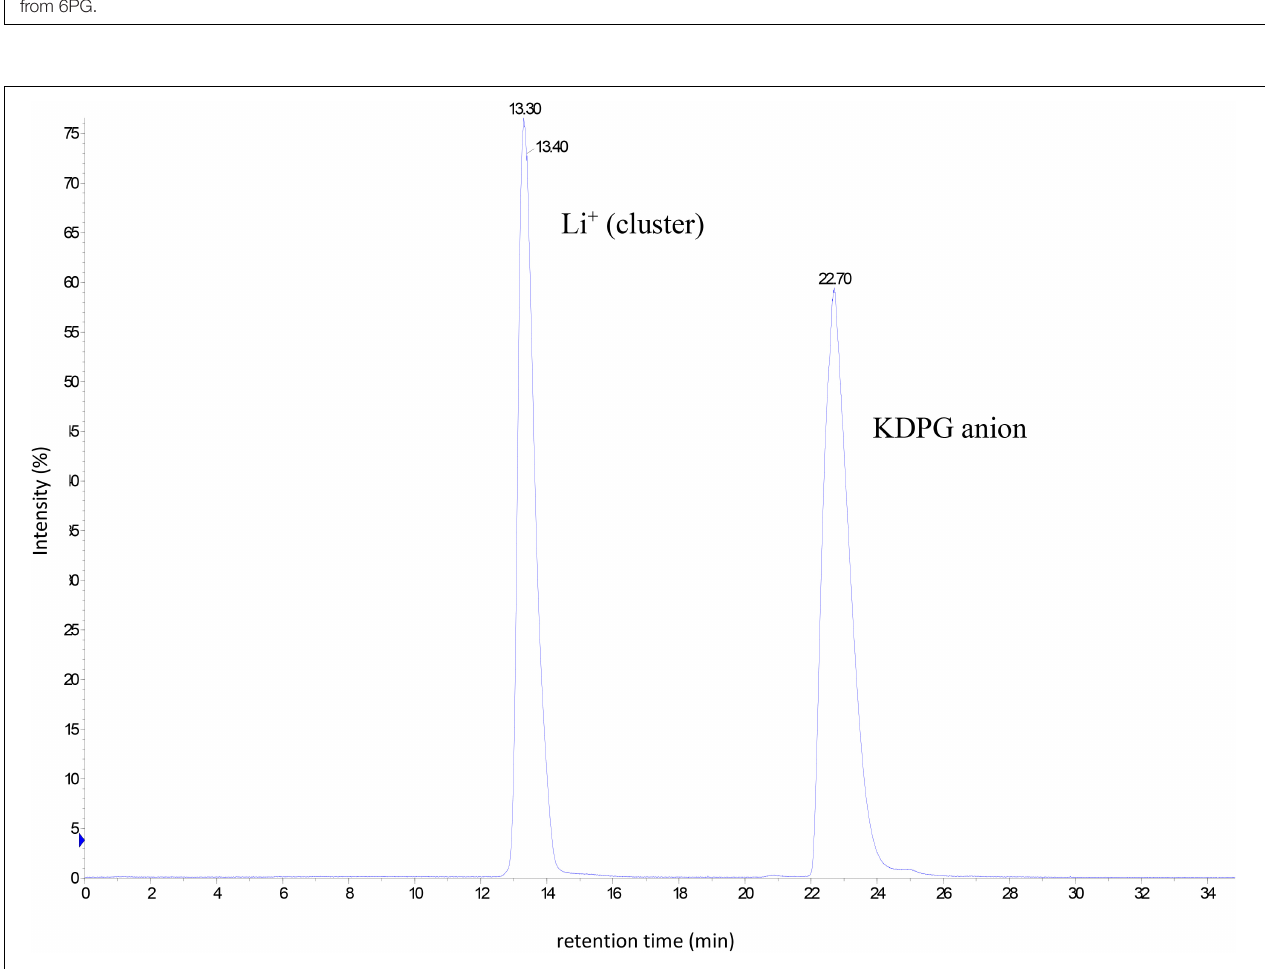
FIGURE 6 | Chromatogram of the HPLC–CAD analysis of the purified product KDPG after lab scale production and purification [0.25 mg ml − 1 , peak at 22.70 min retention time corresponds to a molecular mass of 1 (M–H)– = 258.119 Da, C6H11O9P].